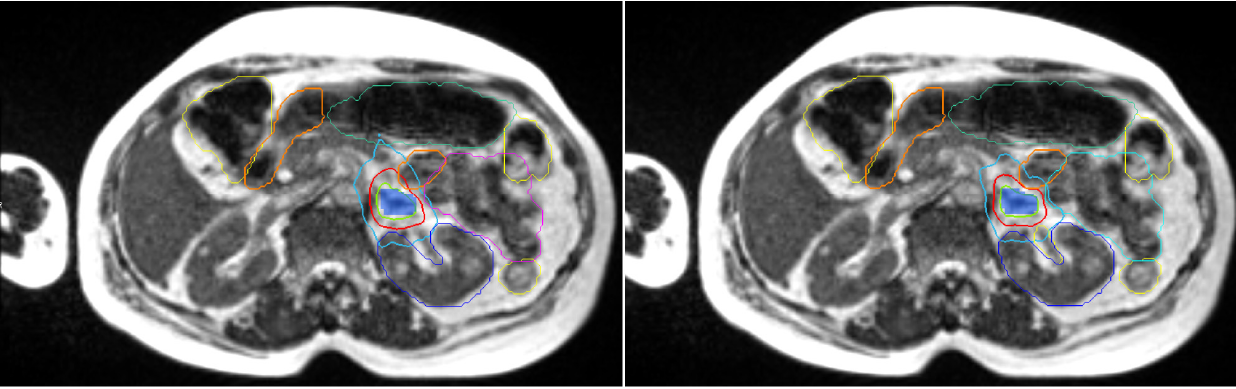
Figure 1. Comparison of dose distribution between predicted ( left ), and adapted/delivered ( right ) dosimetry on MR 0.35-T TRUFISP images for a prescription of 50 Gy in 5 fractions. Isodose line, 47.5 Gy in green, 32 Gy in red, and 20 Gy in cyan. Duodenum in orange, PTV in blue colorwash. PTV coverage was significantly improved for adapted plans compared to predicted plans (median PTV V95% increased from 89.85% to 91.17%, p = 0.0478). The plan adaptation also significantly improved Dmax for all OARs. Figures 2 and 3 show the target volume and organs at risk mean dose variations between predicted and adapted fractions. The OAR’s dosimetric results for the predicted and optimized plans of five and three fractions are presented in Table 5.